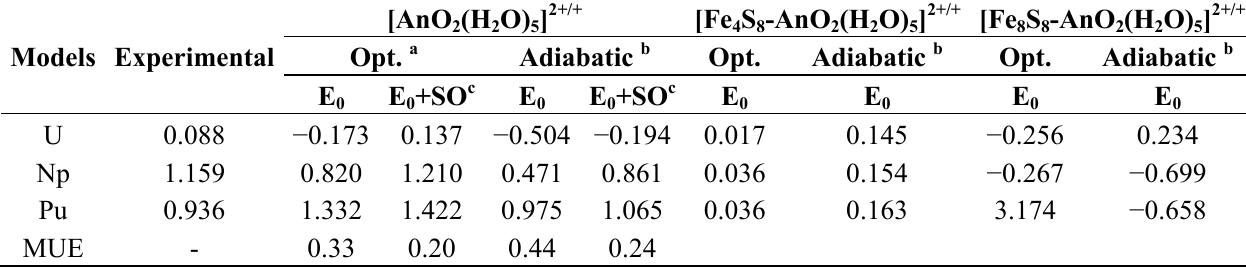
Table 2. Experimental and calculated reduction potentials of actinyl aqua model complexes in aqueous solution